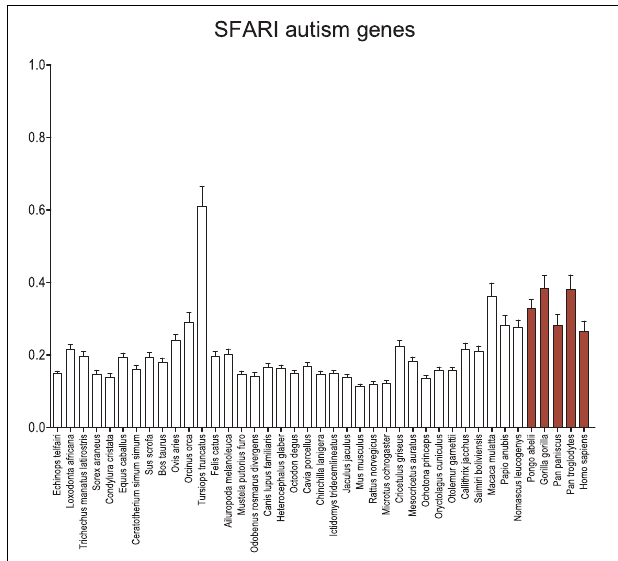
FIGURE 5 | Average d N /d S across taxa of SFARI autism-associated genes. Average d N /d S of genes positively associated with autism based on associations collected in Simons Foundation Autism Research Initiative Gene (SFARI). Average d N /d S ratios suggest changes in selective regime in catarrhines and dophin similar to what is observed for schizophrenia gene sets but a stronger pattern than observed in the GAD autism gene set. Pairwise significance values are shown in Supplemental Table